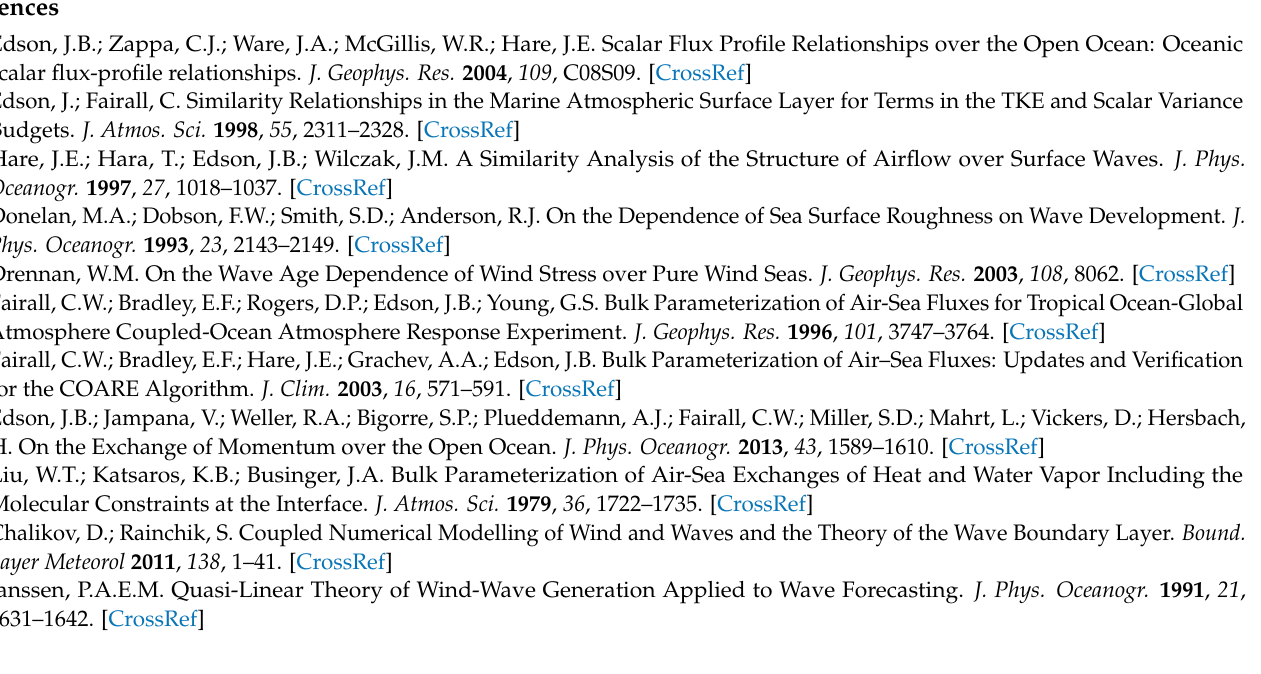
c p is the phase speed of the surface waves at the spectral peak. θ d is the angle between the reference wind and peak wave train